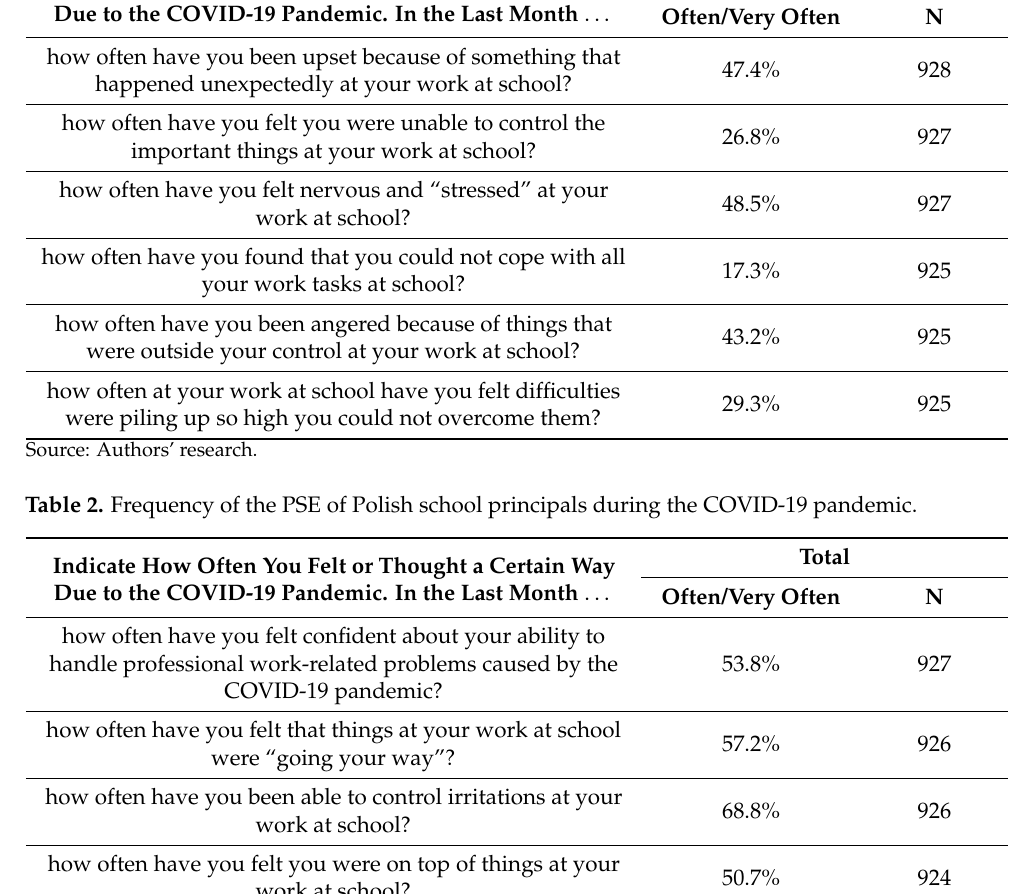
Table 1. Frequeny of the PH of Polish school principals during the COVID-19 pandemic. Indicate How Often You Felt or Thought a Certain Way